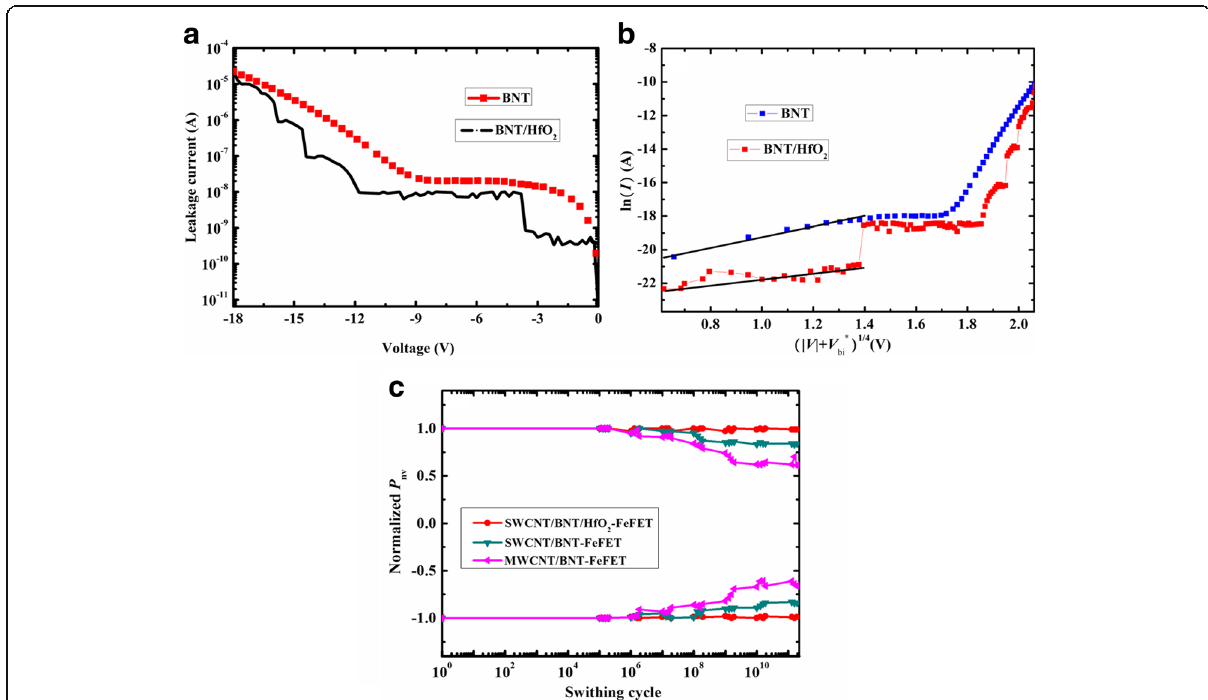
Fig. 6 a Leakage current-voltage characteristics of the BNT/HfO 2 and BNT film. b The fitting curve of the leakage current-voltage characteristics of the BNT/HfO